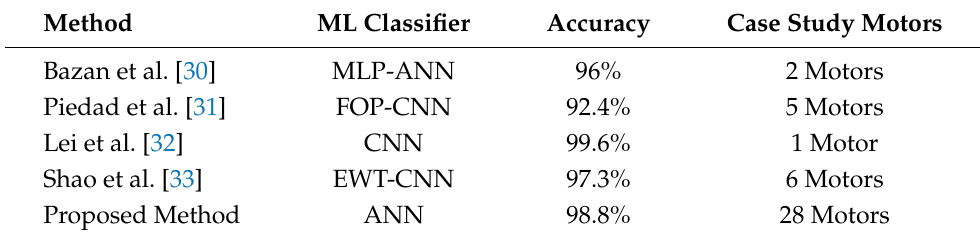
Table 9. Comparison with literature methods based on ML and current